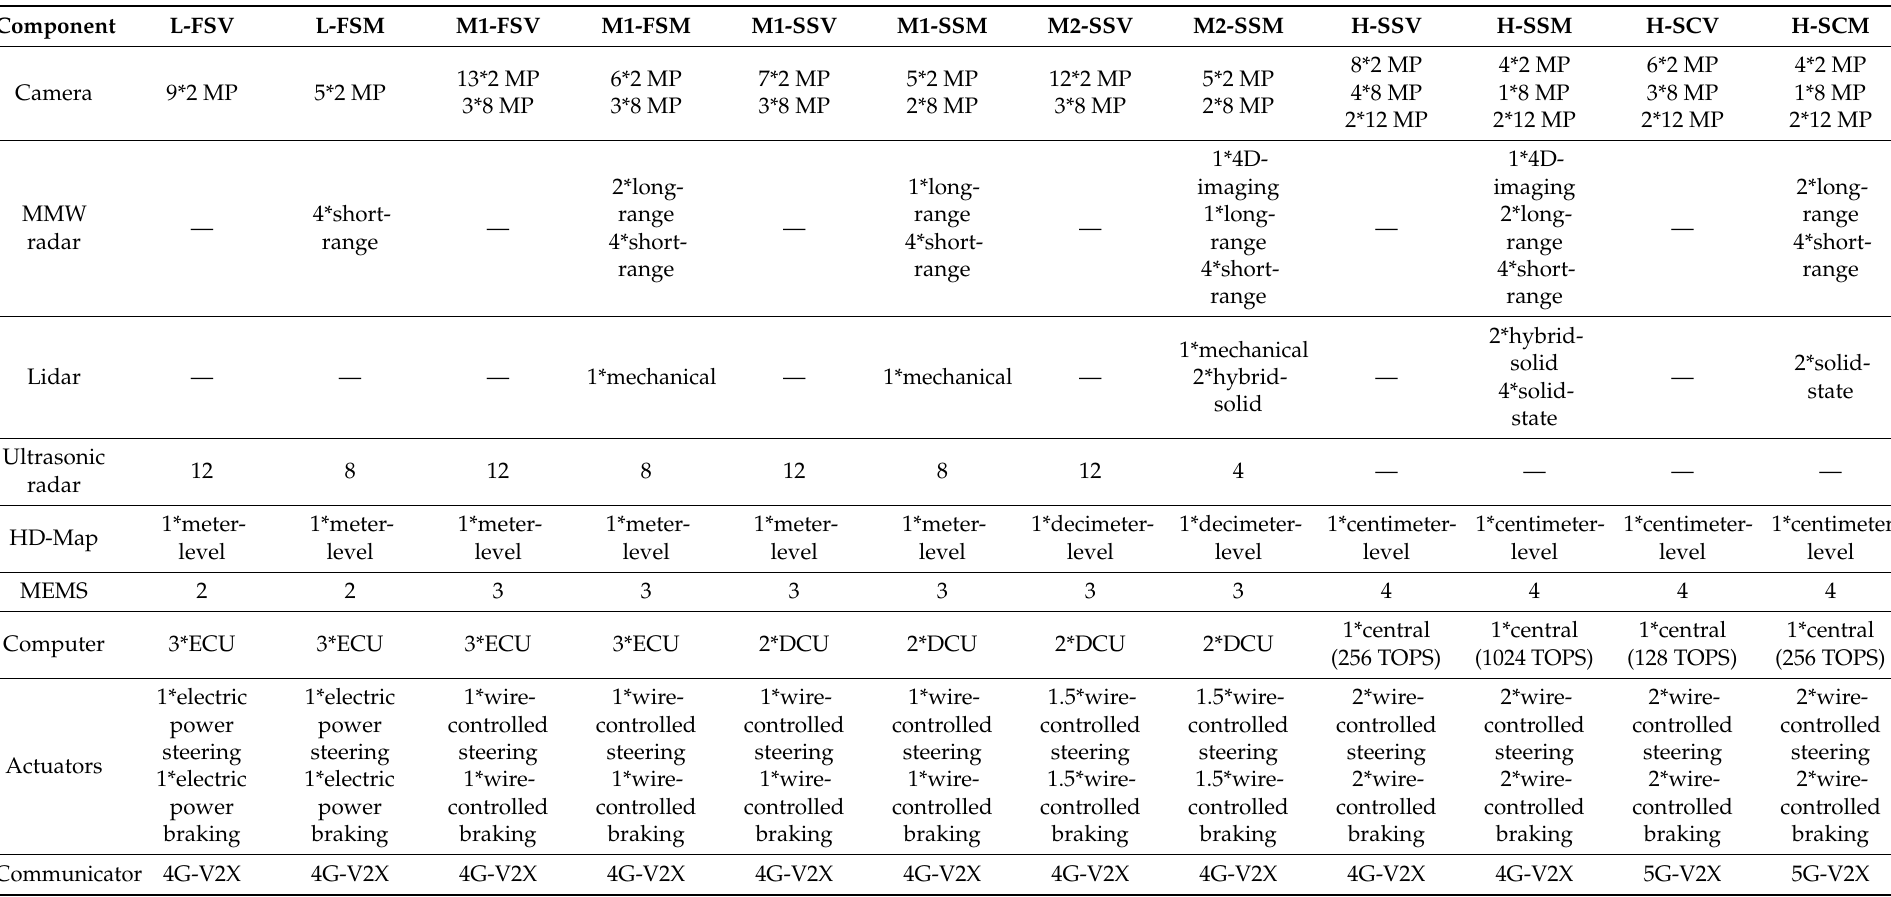
Table 3. Disassembly of technical components of intelligent driving under different technical